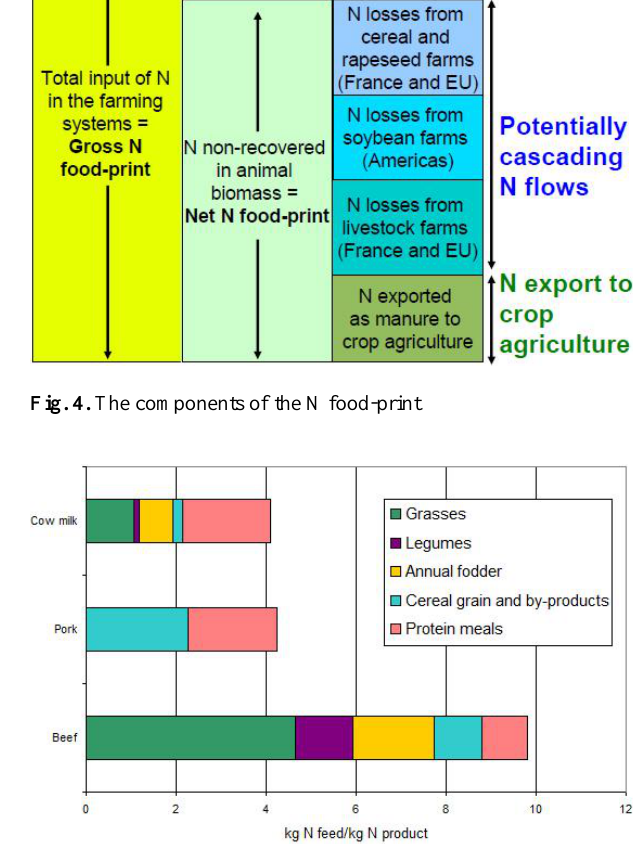
Fig. 5. Average composition of animal rations for the production of fresh milk, pork and beef (kgN in feed/kgN in animal products).